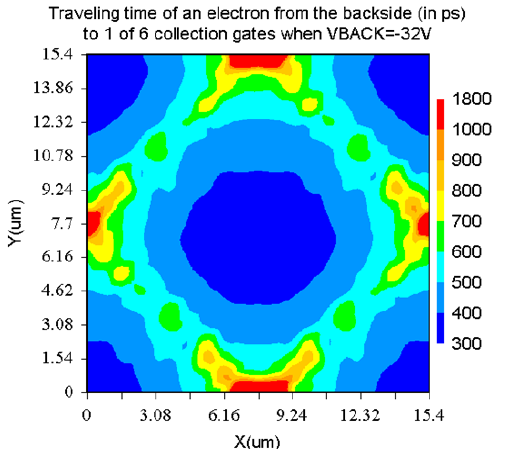
Figure 15. Traveling time of an electron from a point of the backside to 1 of 6 collection gates (ps) (Backside voltage −32 V).